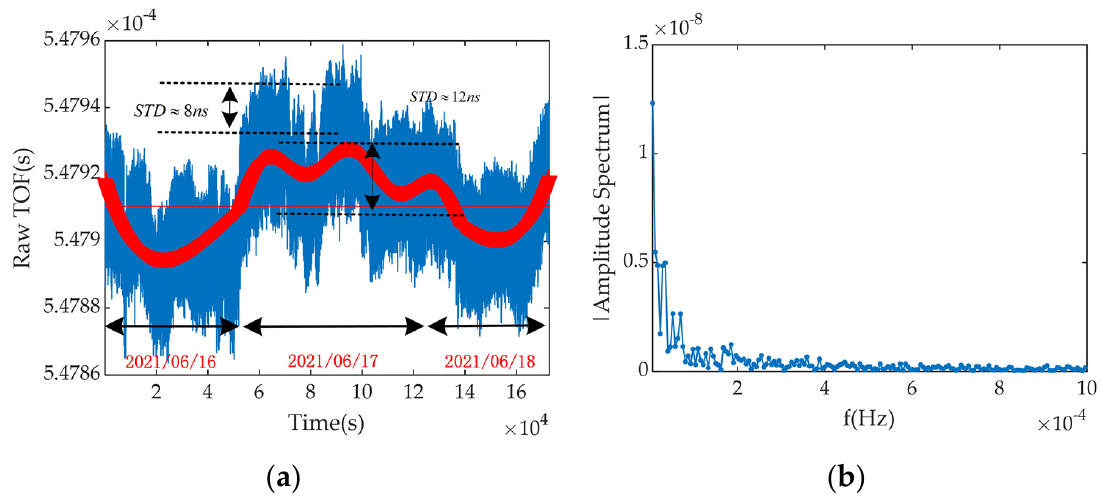
Figure 2. The schematic diagram of measured propagation delay. ( a ) time delay in time domain ( b ) the amplitude spectrum of delays in the frequency domain.